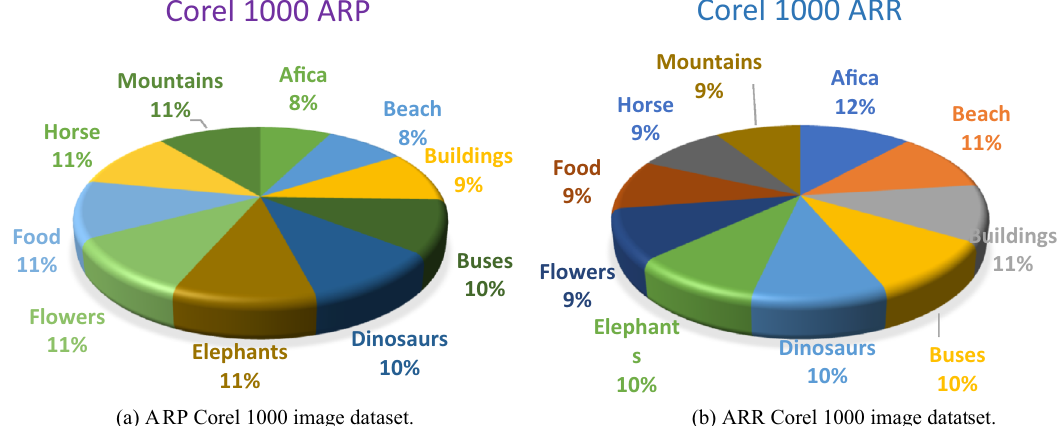
Fig. 19 a ARP Corel 1000 image dataset. b ARR Corel 1000 image